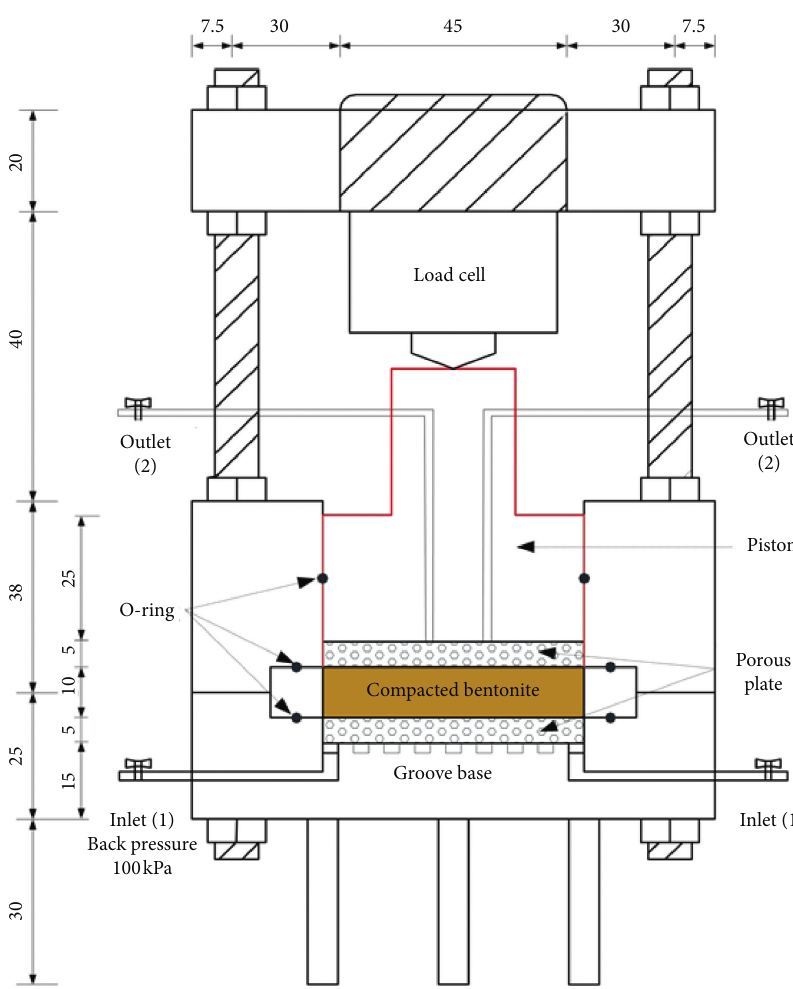
Figure 6: Schematic of the device for testing constant volume (swelling pressure) (unit: mm).